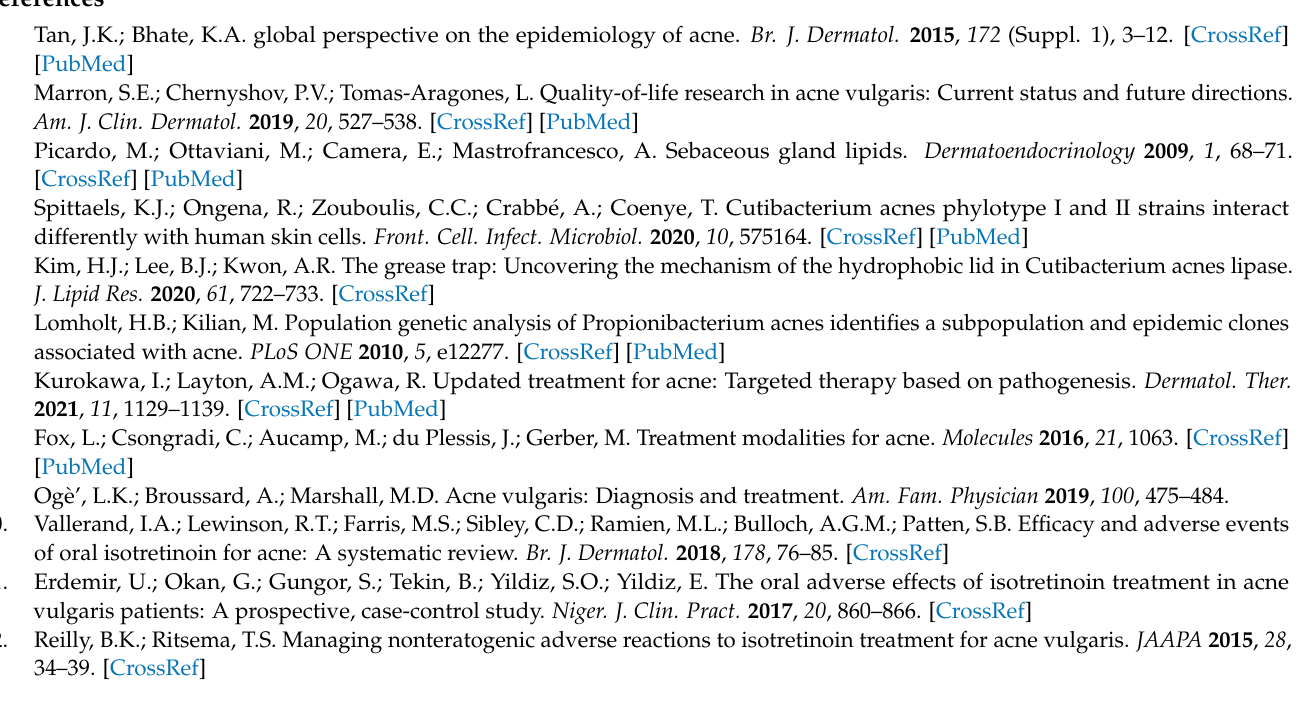
Figure S3: Porphyrin intensity analysis by VISIA®CR 2.3 on Caucasian volunteers (cheek and nose areas) after 28 days of application of cream containing M. indica at 1% or placebo; Table S1: Results for maclurin analysis; Table S2: Results for iriflophenone analysis. Refs. [34–37] are cited in the Supplementary